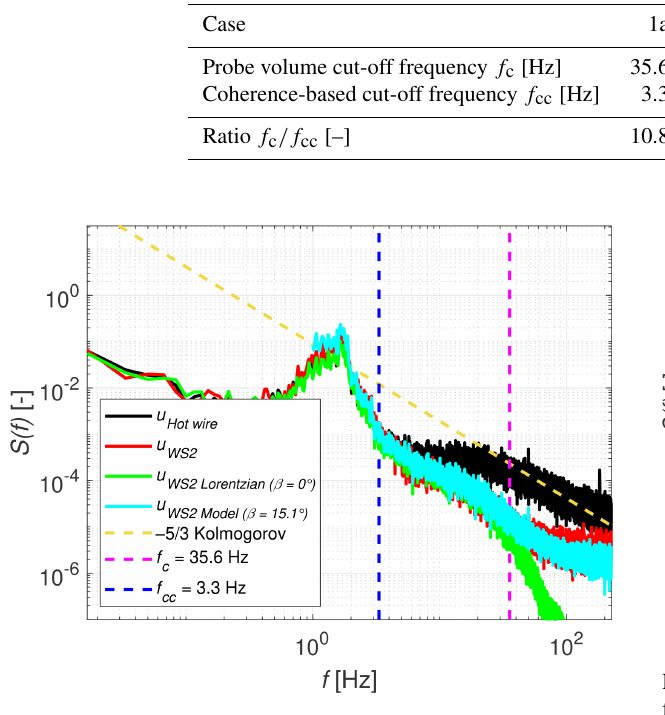
Figure 22. Spectrum of WindScanner 2 (measurements and model) for a turbulence intensity of 3% (Case 1a).